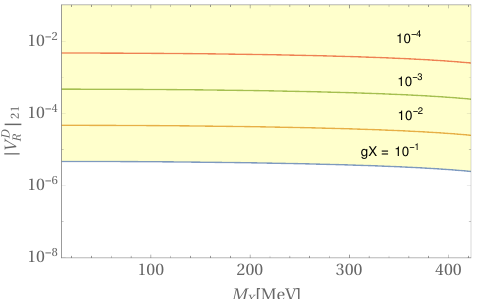
Figure 2 . The (cid:13)avor changing matrix element j V d j 21 . The region above the lines is constrained according to